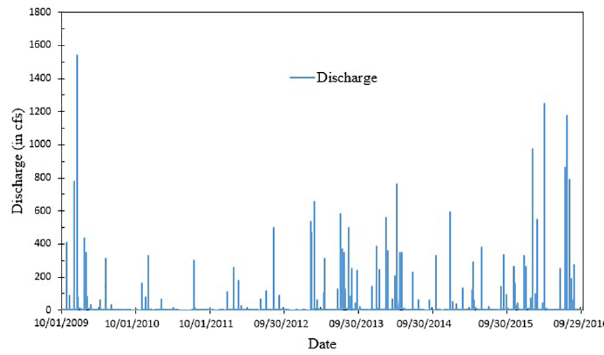
Figure 7. SMA Model Result of Soapstone Branch Catchment (Oc- tober 2009–September